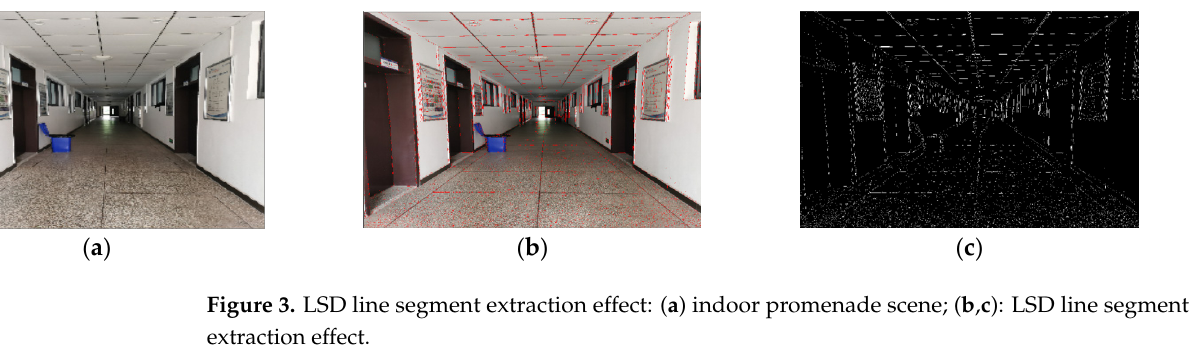
Figure 4. Various line segments: ( a ) the main directions of adjacent line segments are inconsistent; ( b ) adjacent line segments are not in the peripheral matrix of the main line segment; ( c ) set of line segments that meet the conditions for merging.